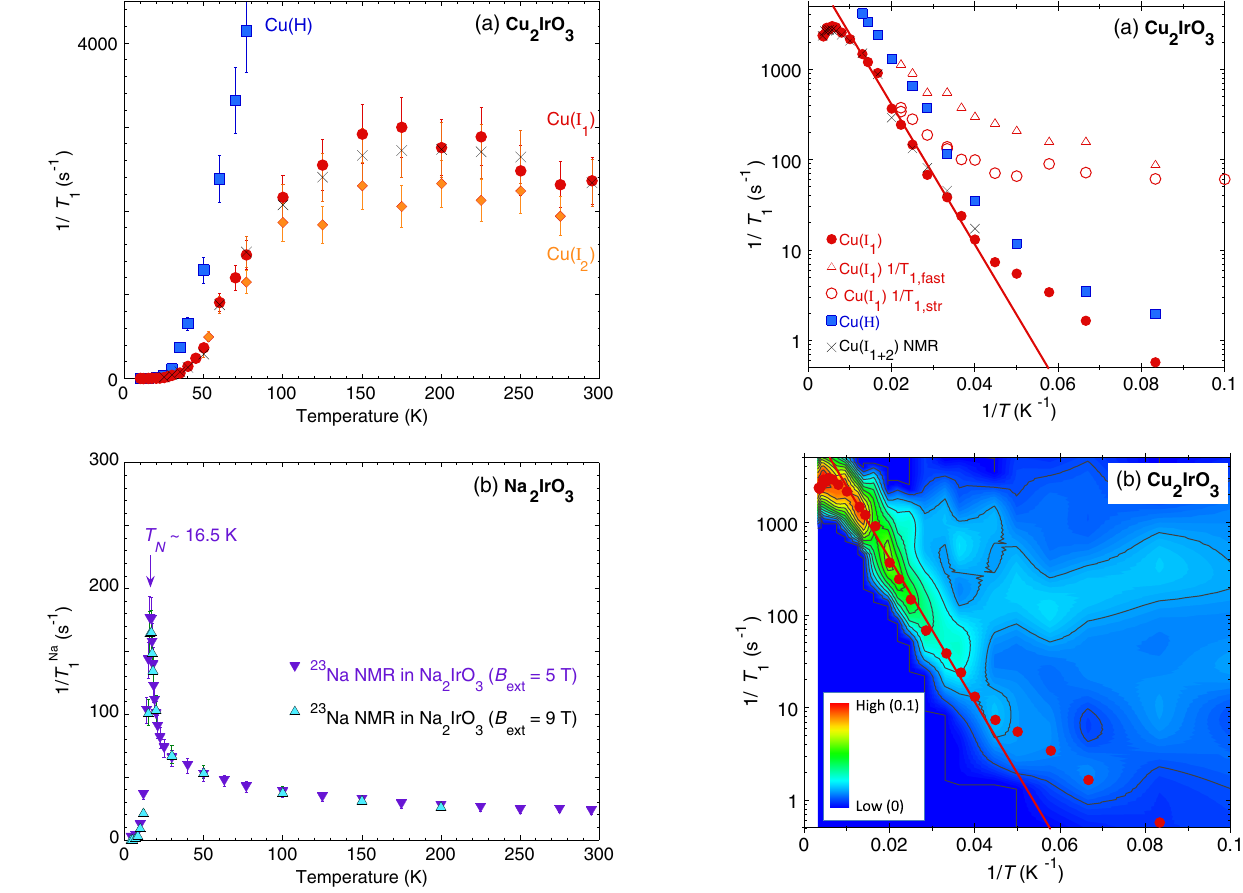
0 FIG. 7. (a) The same NQR and NMR 1 =T 1 results as in FIG. 6. (a) Filled symbols: intrinsic 1 =T 1 measured in B ext ¼ Fig. 6(a), plotted as a function of inverse temperature 1 =T at with NQR at 63 Cu ð I 1 Þ , 63 Cu ð I 2 Þ , and 63 Cu ð H Þ sites of Cu 2 IrO 3 . Note that 1 =T 1 plotted below ∼ 60 K is the intrinsic, slow the 63 Cu ð I 1 Þ and 63 Cu ð H Þ sites (filled symbols). The solid line component estimated from the two-component fit with Eq. (A3) shows an activation behavior, 1 =T 1 ∼ exp ð − Δ =k B T Þ with a gap, Δ =k 175 (cid:3) 30 K. Open triangles represent the fast compo- (i.e., 1 =T 1 ¼ 1 =T 1 ; below ∼ 60 K). Also plotted with × B ¼ slow symbols is 1 =T 1 measured for uniaxially aligned powder sample nent 1 =T 1 ; in the two-component fit with Eq. (A3), while open fast 9 T applied along the ab plane for the with NMR in B bullets show the averaged behavior 1 =T 1 ; as estimated from the ext ¼ str superposed peak of 63 Cu ð I 1 Þ and 63 Cu ð I 2 Þ sites. (b) 1 =T Na 1 stretched single exponential fit with Eq. (A2), both at the 63 Cu ð I 1 Þ observed for the interplanar 23 Na ð I Þ sites in a powder sample sites. (b) The color contour plot of the temperature dependence of 5 and 9 T. of Na 2 IrO 3 in B the probability distribution P ð 1 =T 1 Þ of 1 =T 1 at 63 Cu ð I 1 Þ sites ext ¼ measured with NQR, as determined by inverse Laplace transform of M ð t Þ . We overlaid the NQR 1 =T 1 at 63 Cu ð I 1 Þ sites and its activation behavior, 1 =T 1 ∼ exp ð − Δ =k B T Þ , from